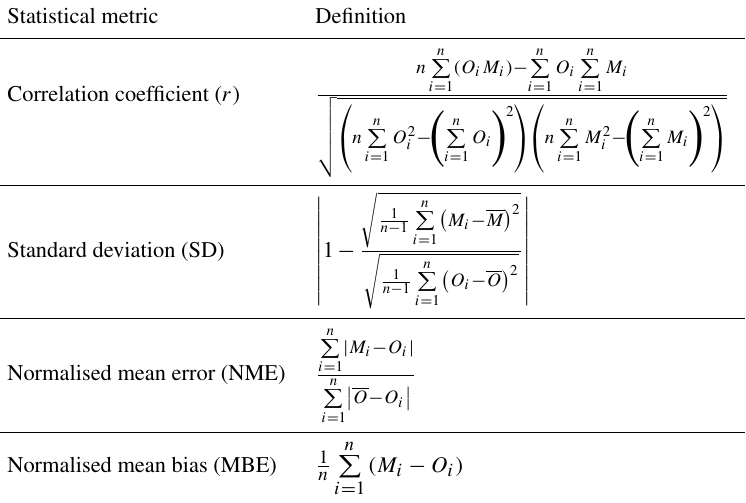
Table A1. Definition of common metrics used to determine ranks against the empirical benchmarks. The terms M and O stand for model and observations respectively, while n denotes the length of the data, and i is the